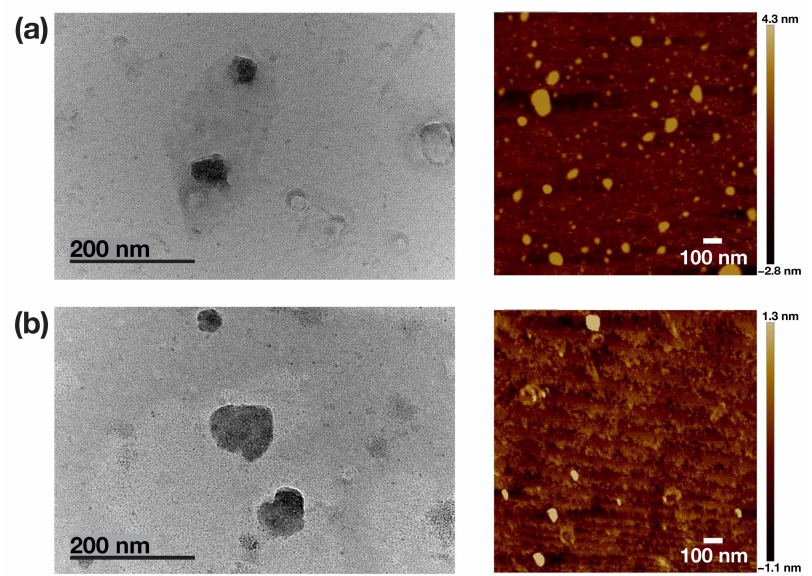
Figure 5. TEM ( left ) and AFM ( right ) images of: ( a ) PLA-SNA; ( b ) PLA- co -PC-SNA.